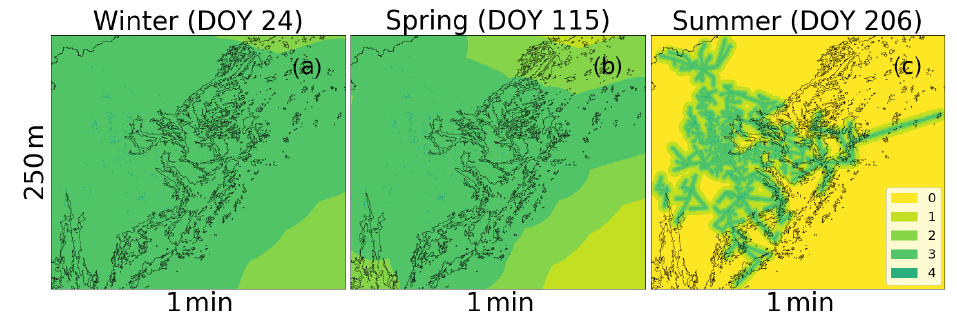
Figure 4. Map of the attainable quality at 1min and 250m resolution for (a) winter (b) spring, and (c) summer precipitation regimes. The colors represent the quality levels equal to Fig. 1a and